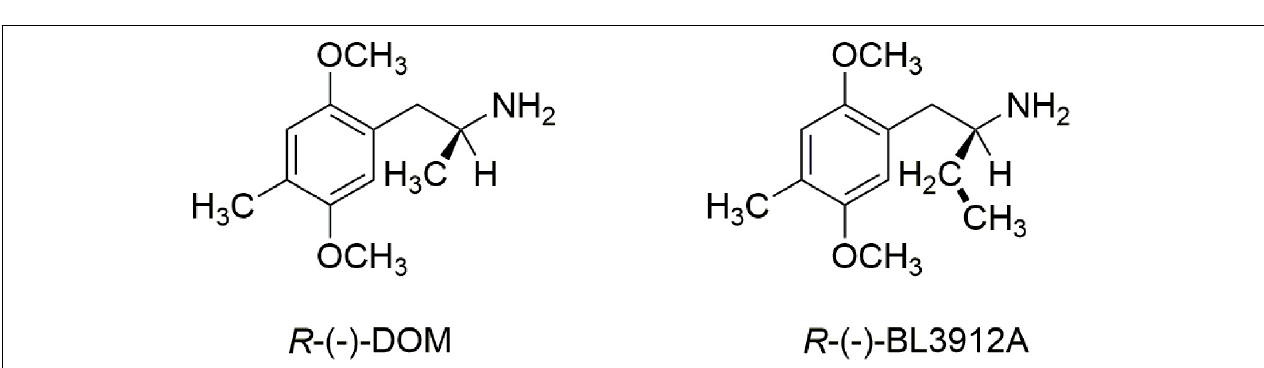
FIGURE 2 | A comparison of R -(–)-DOM with its inactive α -ethyl analog, R -(–)-BL3912A.